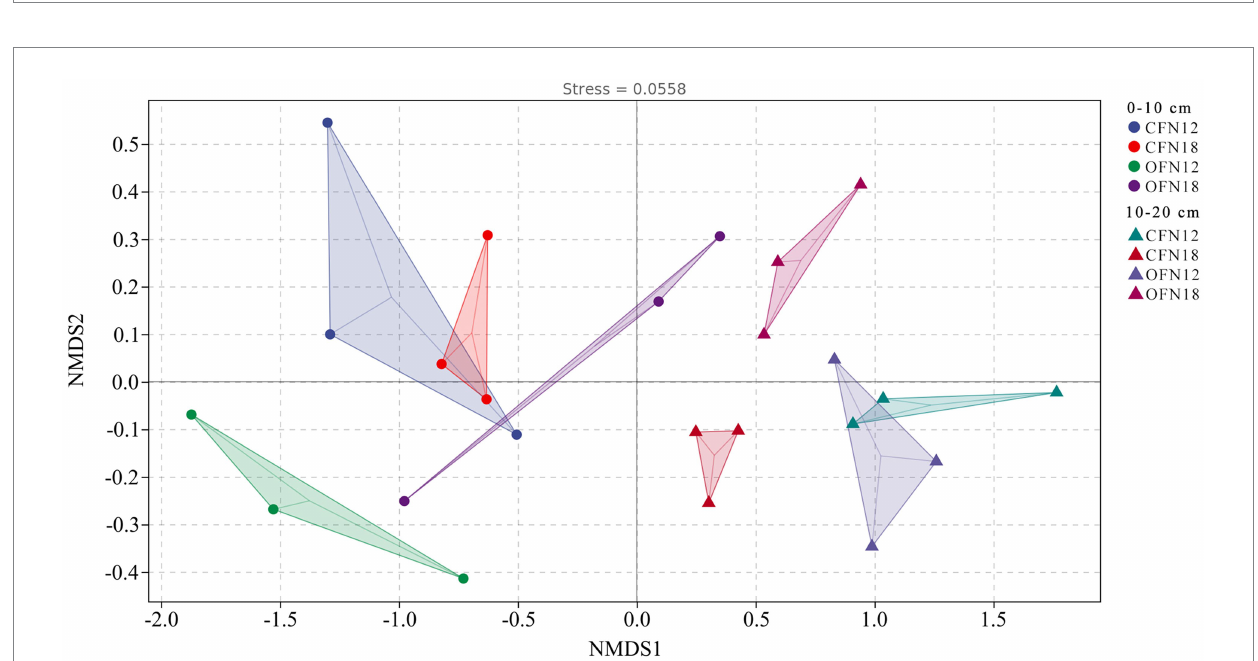
FIGURE 5 Non-metric multidimensional scaling analysis score plots of bacteria based on the Bray–Curtis